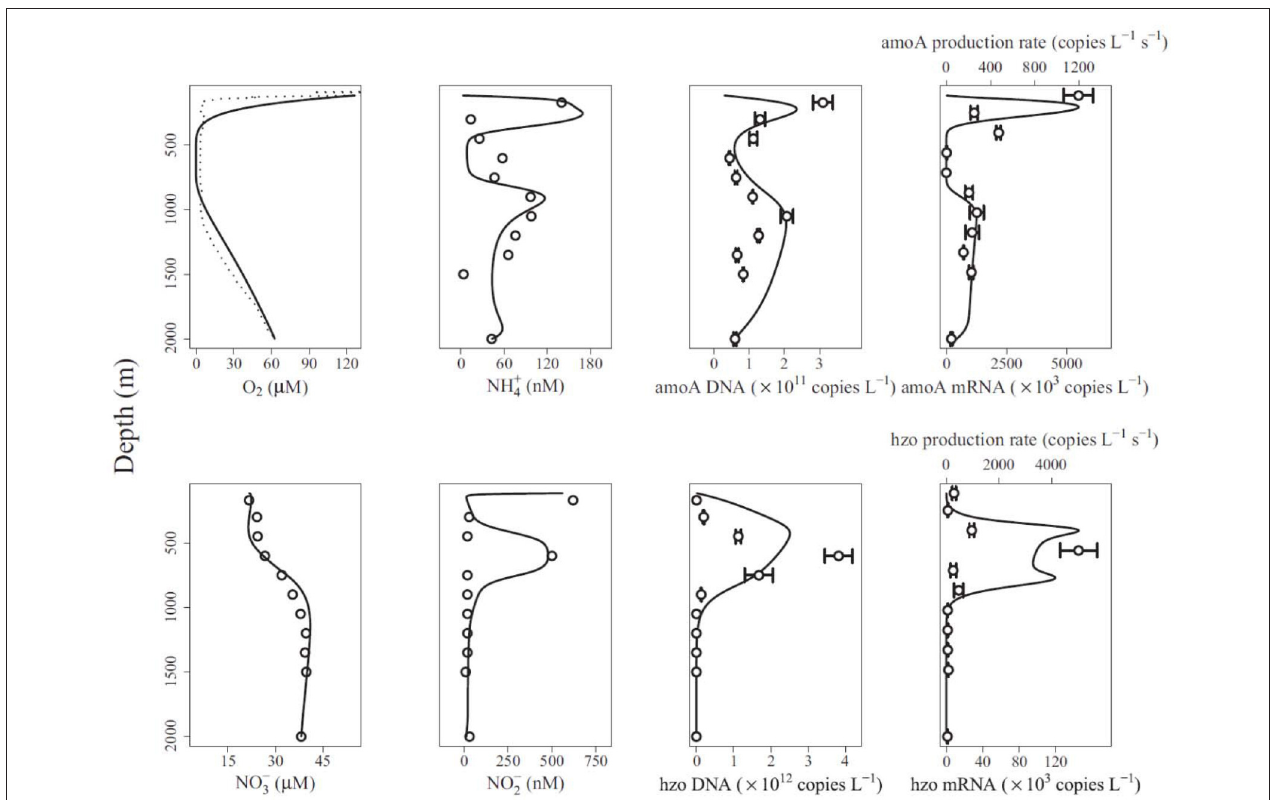
FIGURE 3 | Comparison of gene-centric model predictions (solid lines) to observations (dotted line in top left and symbols in other panels) of metabolites, gene and mRNA levels in the Arabian Sea oxygen minimum zone. From Reed et al. (2014). Copyright © (2014) by the National Academy of Sciences. The figure shows an oxygen low from about 400 to 900m and a coincident low in ammonia monooxygenase ( amoA ) DNA and mRNA, and an increase in anaerobic ammonium oxidation (anammox, hydrazine oxidoreductase, hzo ) DNA and